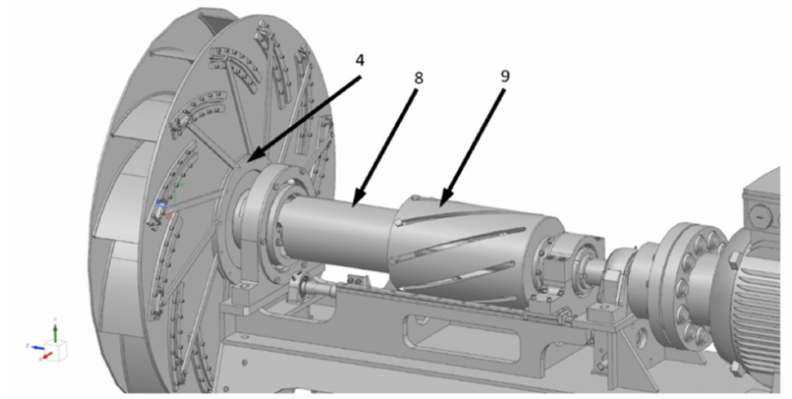
Figure 7. Impeller geometry change mechanism—parts mounted on the drive